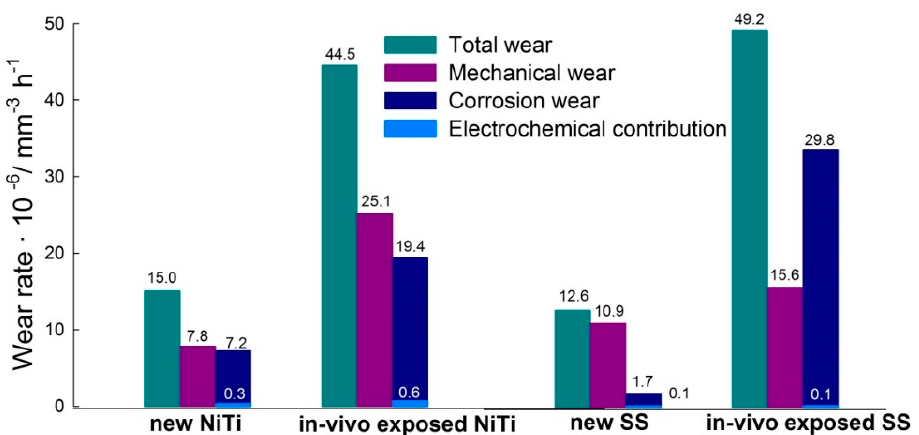
Figure 4. The contribution of mechanical and corrosion wear to total wear for the new and in vivo NiTi and SS archwires.